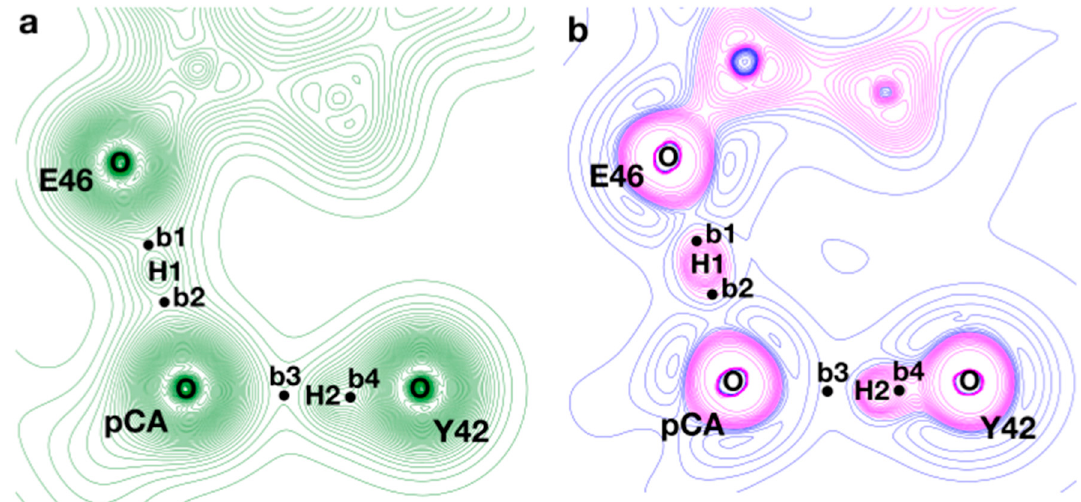
Figure 6. ρ ( a ) and ∇ 2 ρ ( b ) contour maps in the plane that contains the two short HBs between pCA and E46/Y42. The structure examined corresponds to a frame extracted from the QM/MM trajectory, which is representative of the minimum found in the potential of mean force (PMF). The black circles ( b1 – b4 ) represent the location of the bond critical points found between the atoms involved in the HBs. In the case of ∇ 2 ρ , positive and negative contour lines are displayed in blue and magenta, respectively.